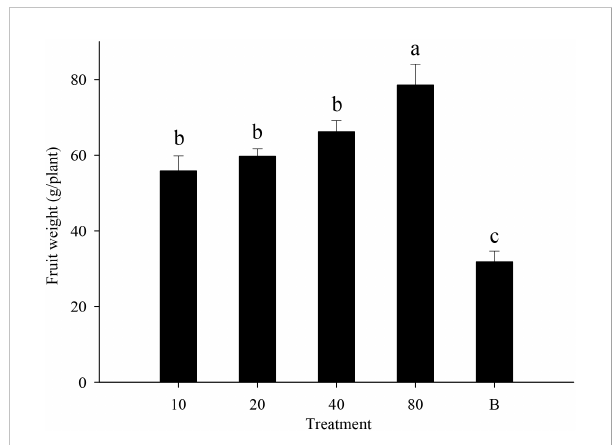
FIGURE 8 Fruit weight of strawberry (g/plant) in different experimental treatments during winter 2020-21. Numbers in the X axis refer to the total number of hover fl y adults that were released i.e., 10, 20, 40 or 80 pairs; data are also plotted for a bagging (B) treatment. Different lowercase letters indicate statistically signi fi cant differences between treatment groups (One-way ANOVA, P <0.05, Tukey ’ s HSD post-hoc